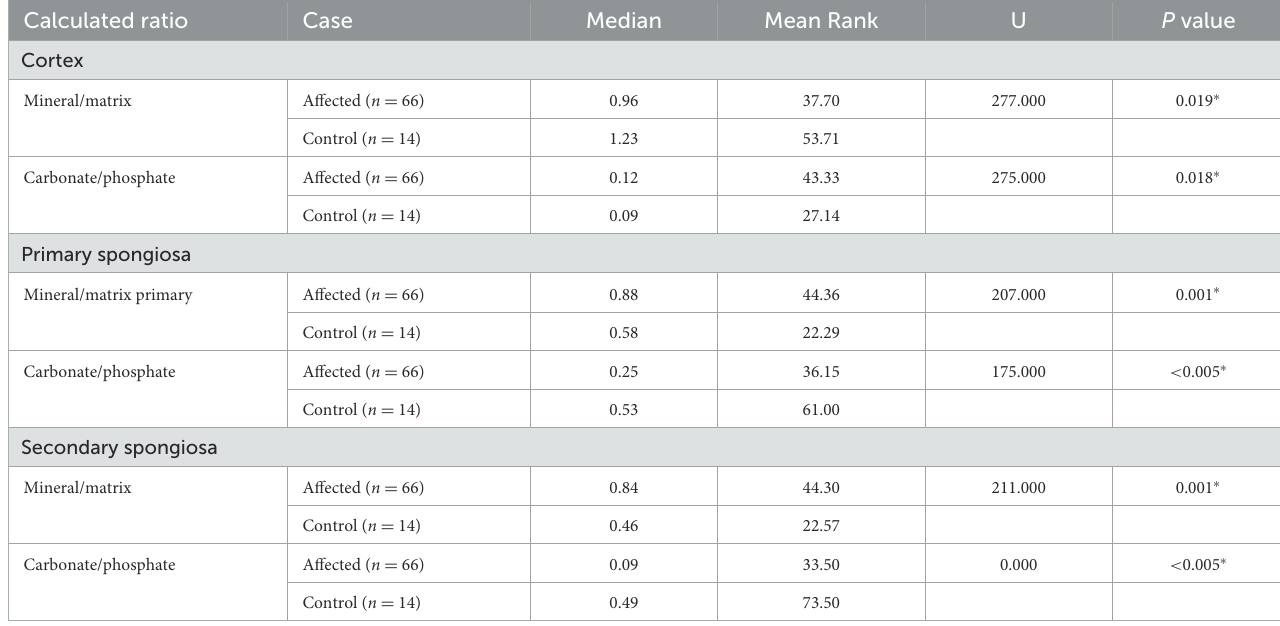
TABLE 2 Mann Whitney U test results of FTIR spectra ratios by humeral bone location (cortex, primary, and secondary spongiosa) obtained from affected and control cows. Calculated ratio Case P value